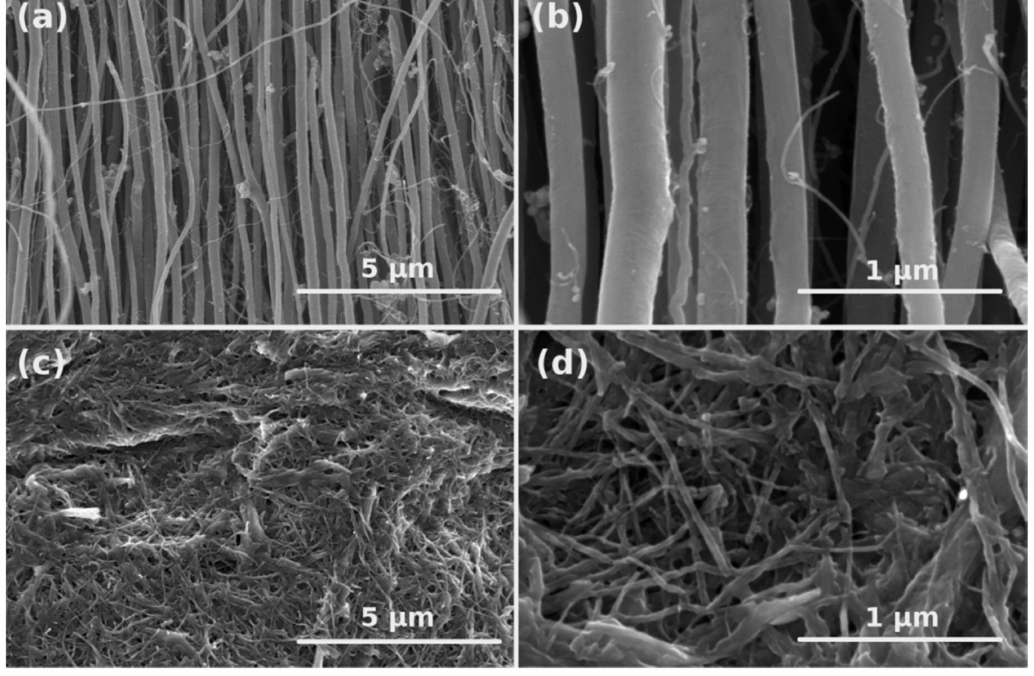
Figure 1. Low-and high-magnification SEM images of as-synthesized ( a , b ) and oxidized ( c , d ) CNTs,